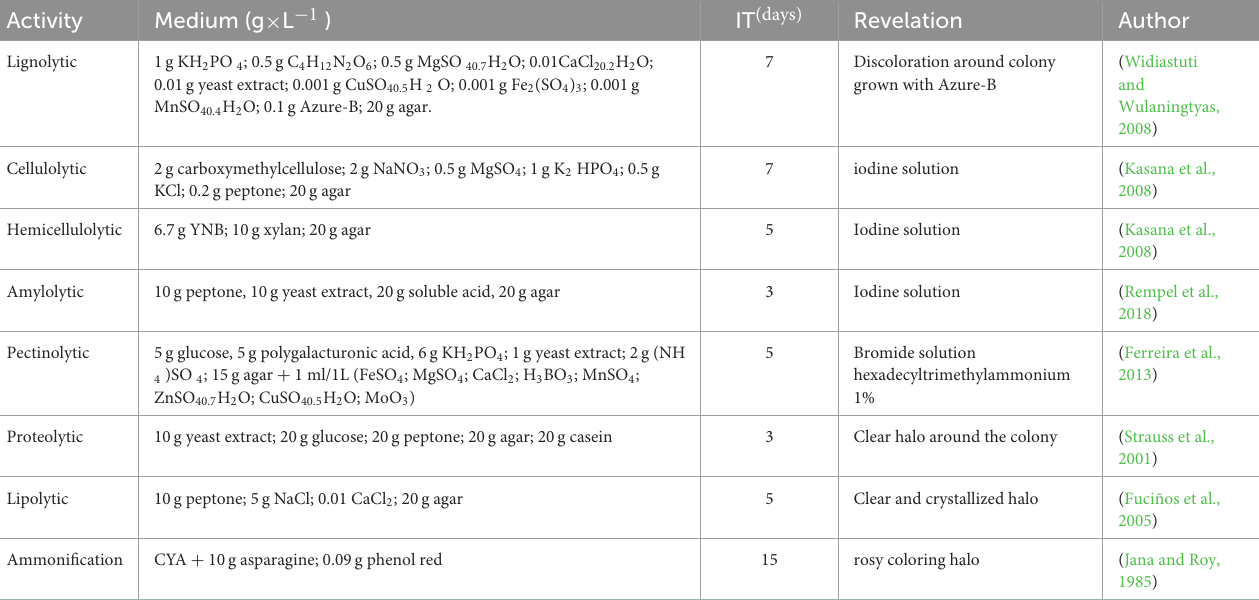
TABLE 6 Enzymatic activities and their respective culture media, incubation times and development mode.